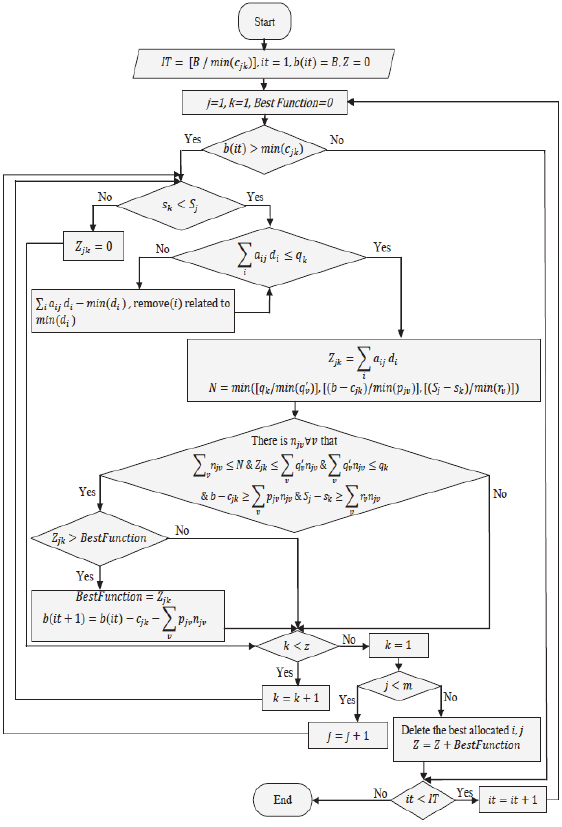
Fig. 1. The flowchart of the heuristic